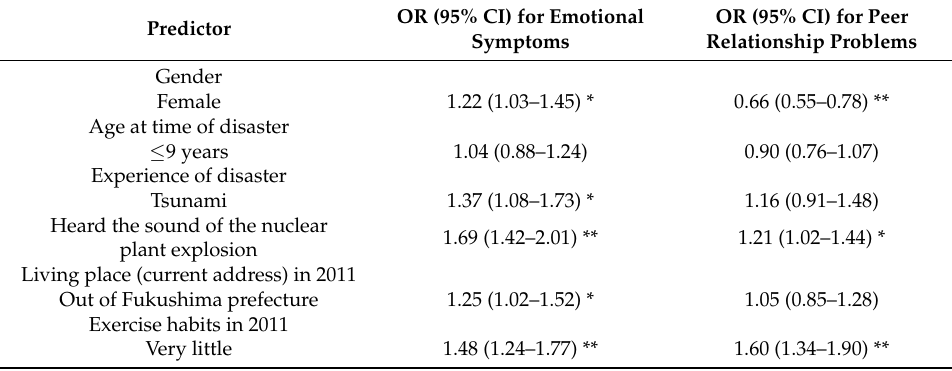
Table 2. Multivariate logistic regression analysis of the very severe trajectory group, for emotional symptoms and for peer relationship problems.